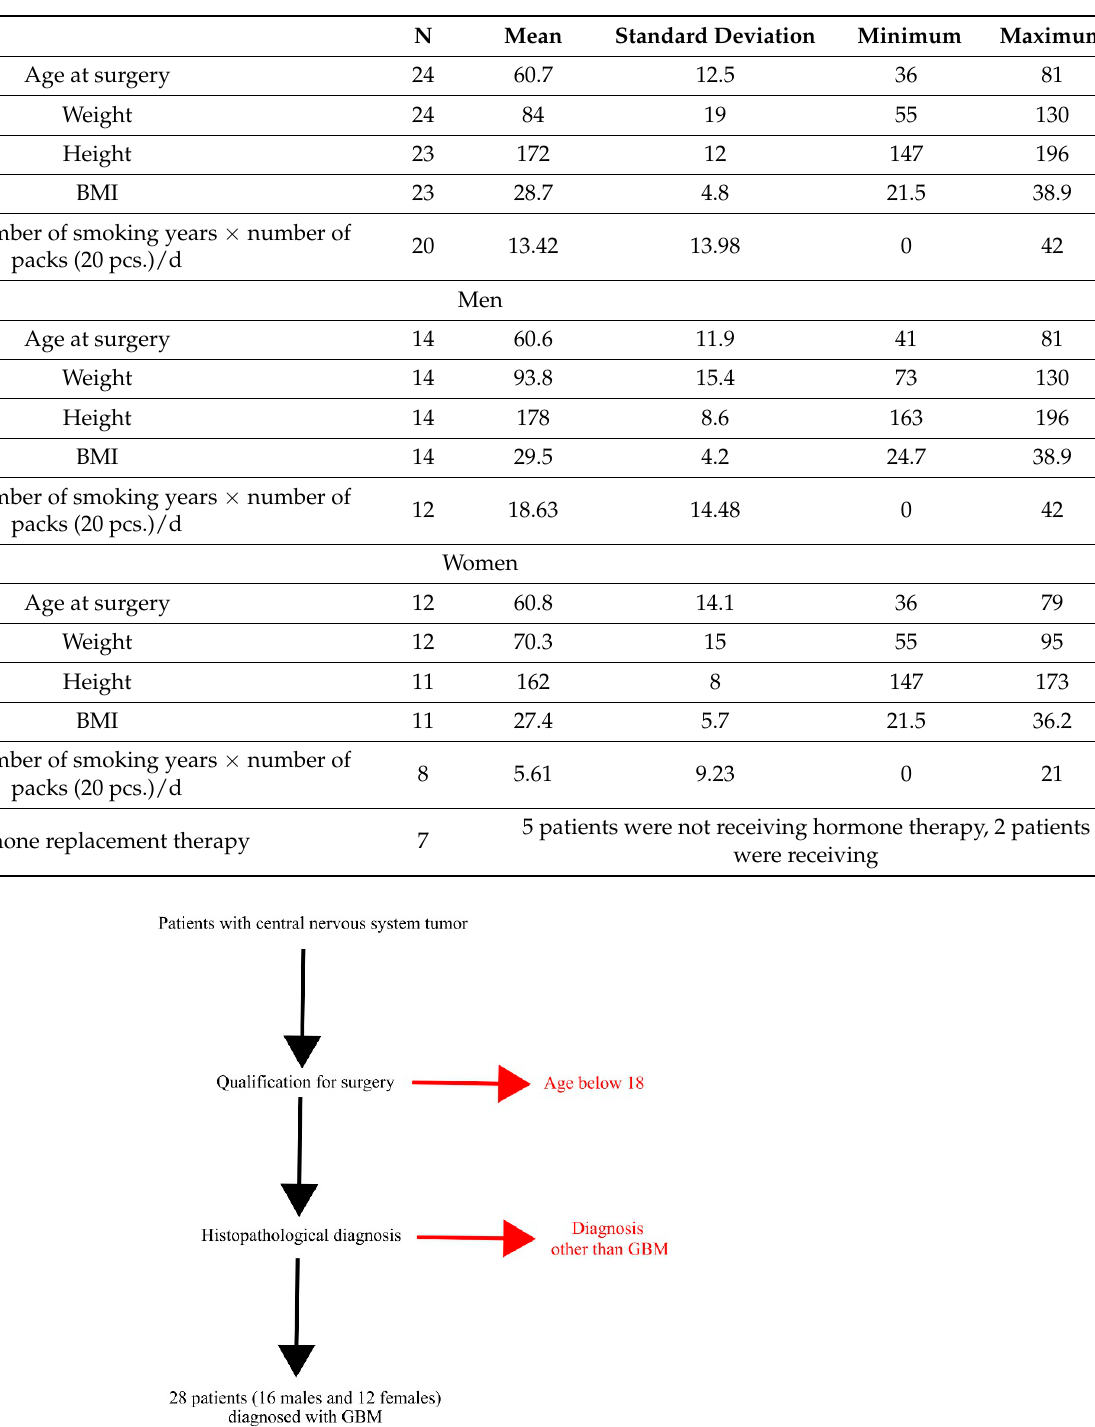
Table 1. The statistical characteristics of the patients.